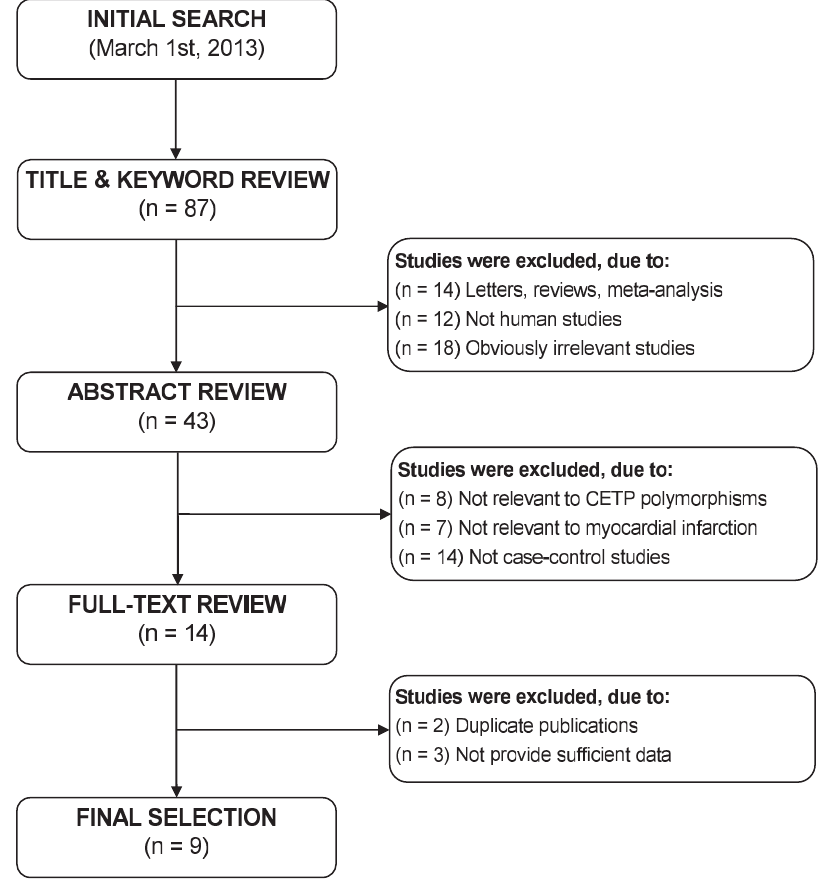
Figure 1. Flow chart shows study selection procedure.